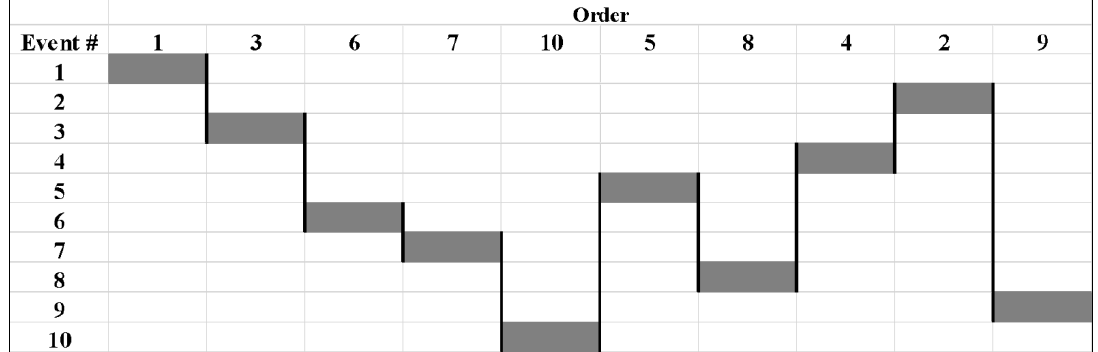
Figure 9. Optimal schedule of fictitious genetic algorithm example.